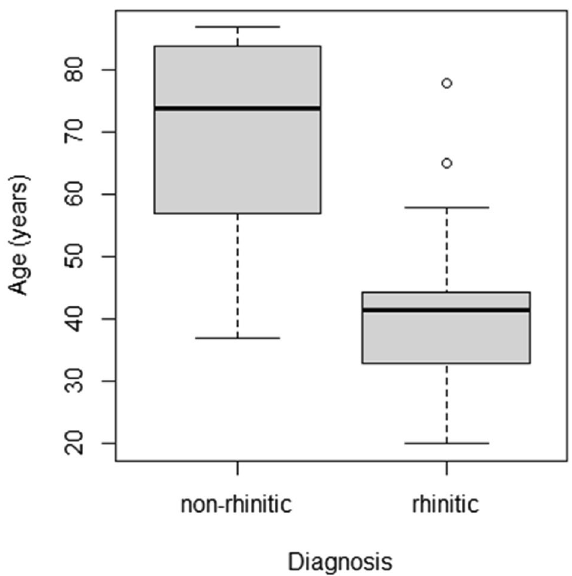
Figure 4. Boxplot of age of rhinitis-diagnosed and non-rhinitis